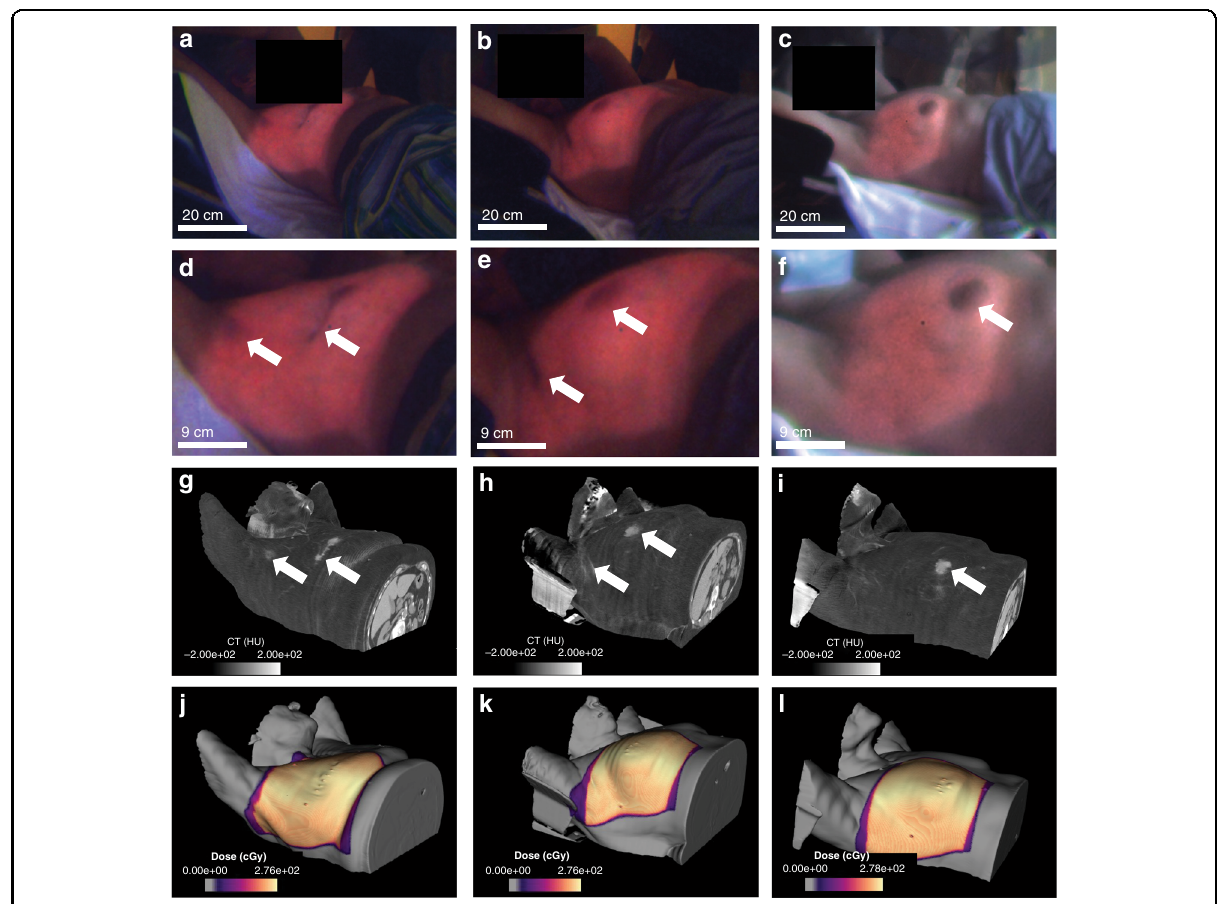
Fig. 4 Coincidence of Cherenkov color variations and surface tissue features. Cherenkov images of whole breast radiotherapy treatment of three patients a – c , with zoomed-in views below d – f . The outer edge of the radiation fi eld delineated by the Cherenkov emission corresponds with the surface dose distributions extracted from the treatment planning system ( j – l ). Surface-weighted tissue density maps extracting from the simulation CT scan ( g – i ) show high-density features including the nipple-areolar complex, axillary scars, and surface vasculature, which are coincident with color variations in the corresponding Cherenkov images as highlighted with white